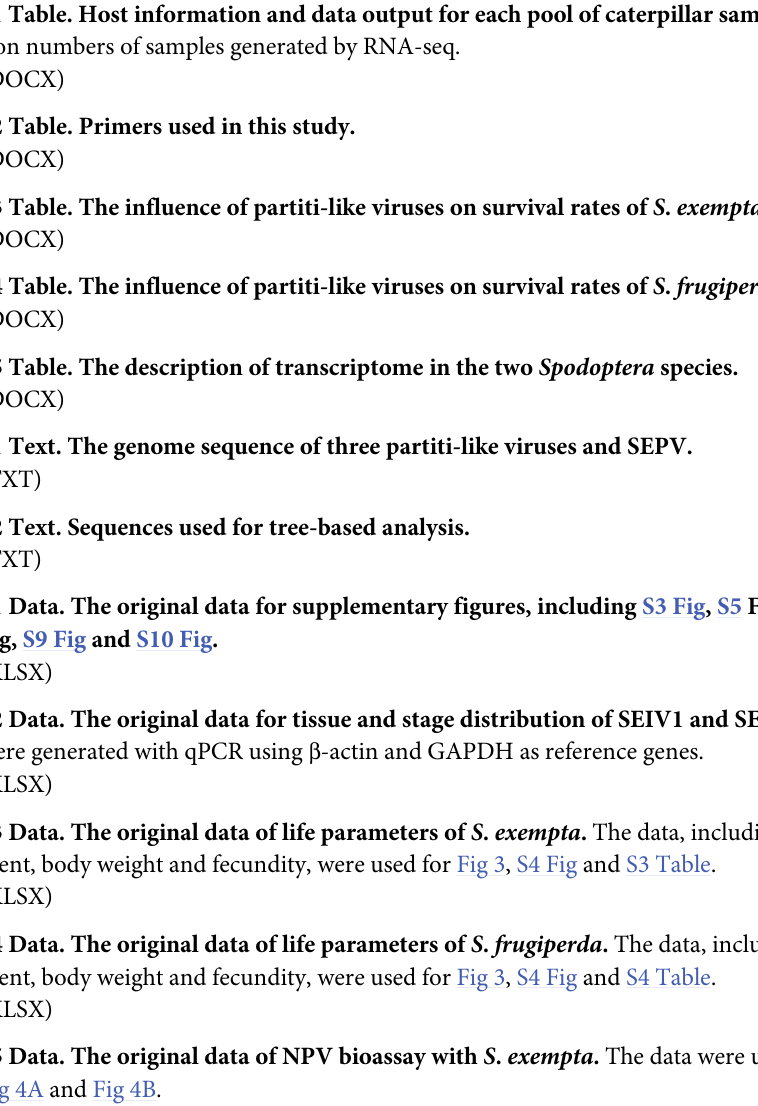
S1 Table. Host information and data output for each pool of caterpillar samples. The acces- sion numbers of samples generated by RNA-seq. S2 Table. Primers used in this study. (DOCX) S3 Table. The influence of partiti-like viruses on survival rates of S . exempta . (DOCX) S4 Table. The influence of partiti-like viruses on survival rates of S . frugiperda . (DOCX) S5 Table. The description of transcriptome in the two Spodoptera species.